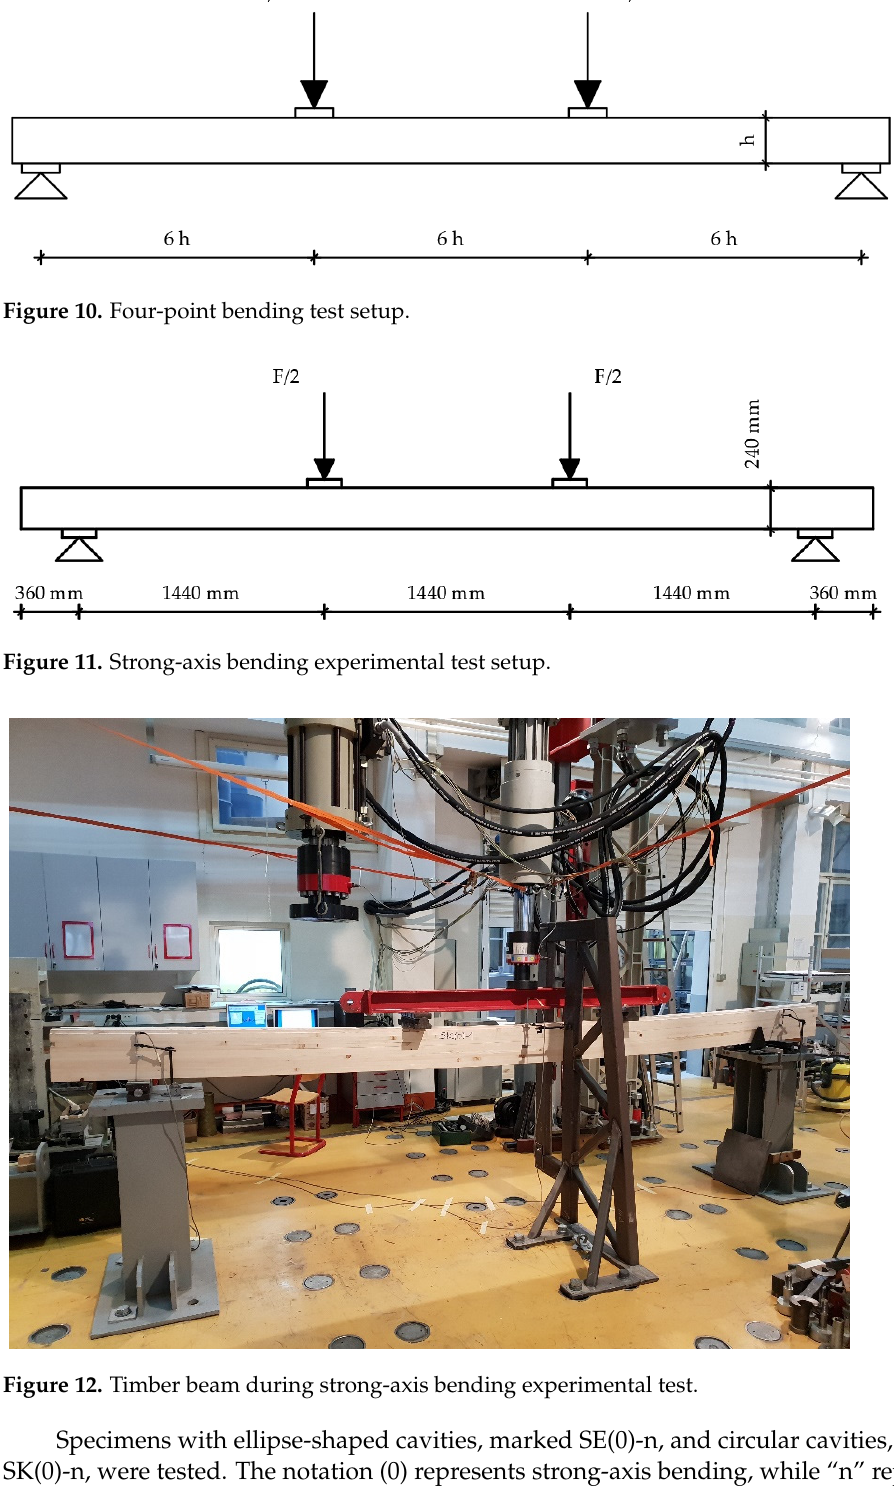
Figure 10. Four-point bending test setup.